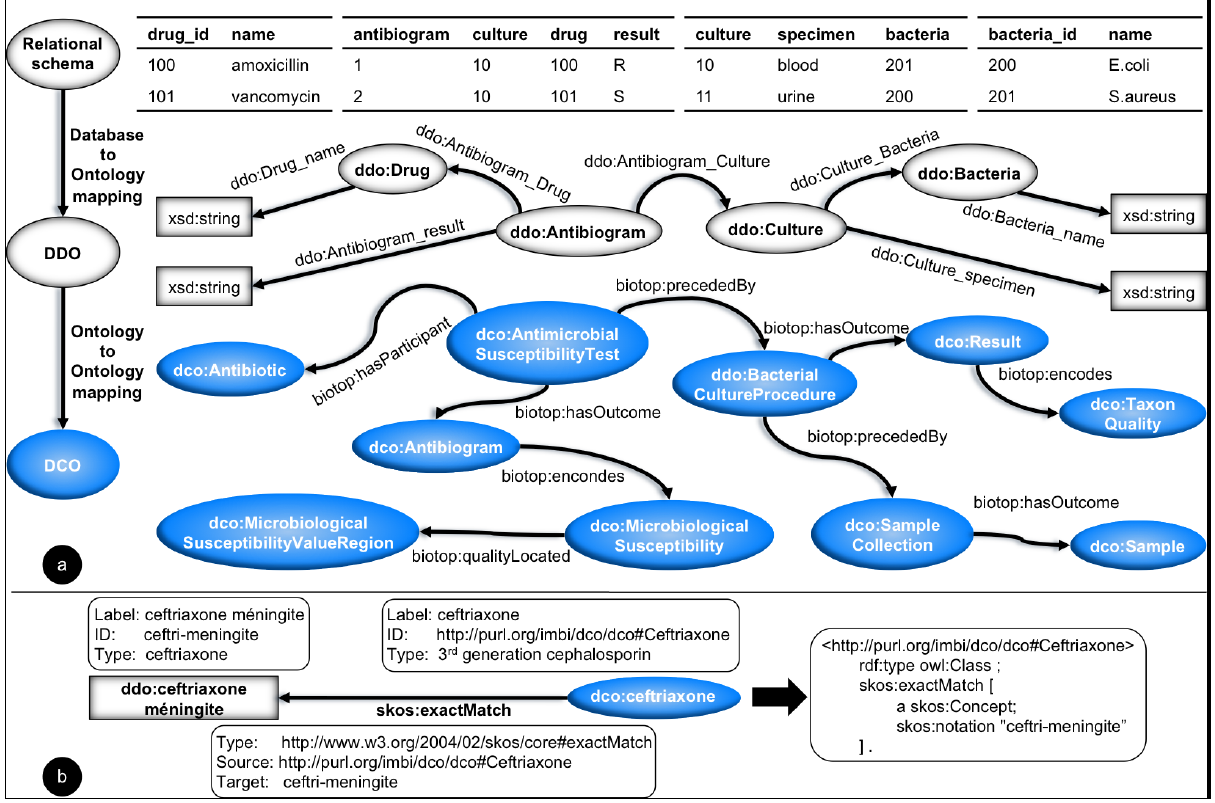
Figure 5. The hybrid ontology-driven interoperability mapping model. White elements represent local-level concepts and blue elements represent shared knowledge. (a) Local entity-relationship schemata are formalized by the data definition ontologies (DDOs). Mappings between DDO data elements and DebugIT Core Ontology (DCO) link local concepts to the global knowledge. (b) Example of a semantic mapping: concept map diagram (left) and RDF/Notation3 representation